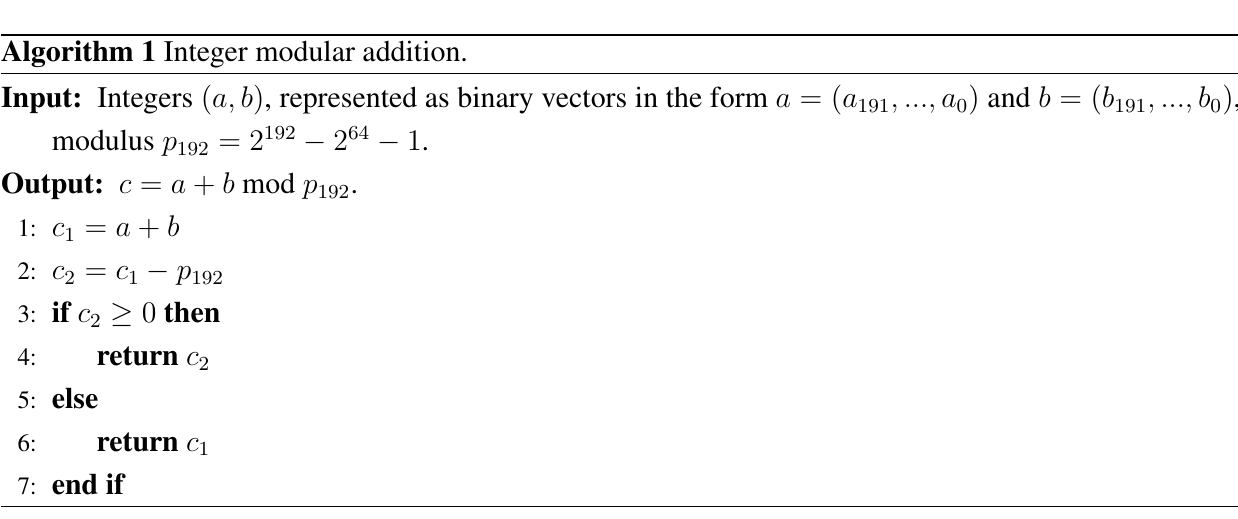
Algorithm 1 Integer modular addition.